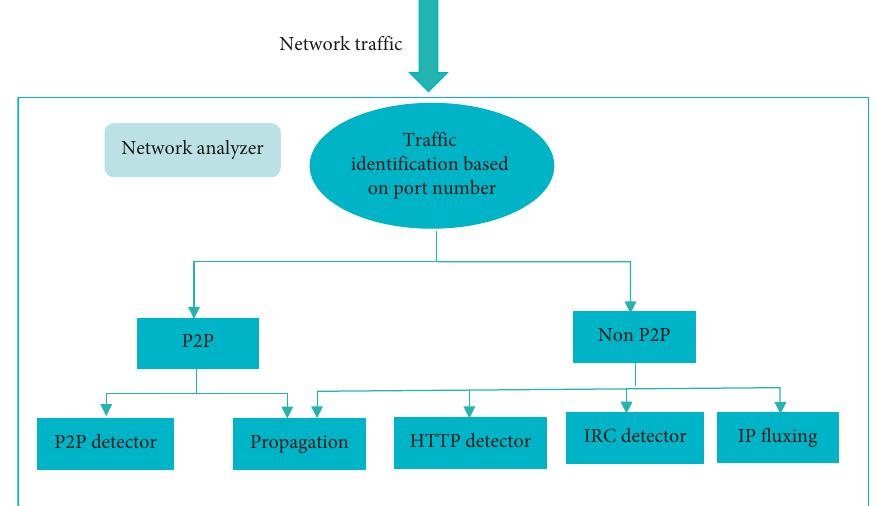
Figure 4: Network analyzer components. Table 5: Monitored network failure